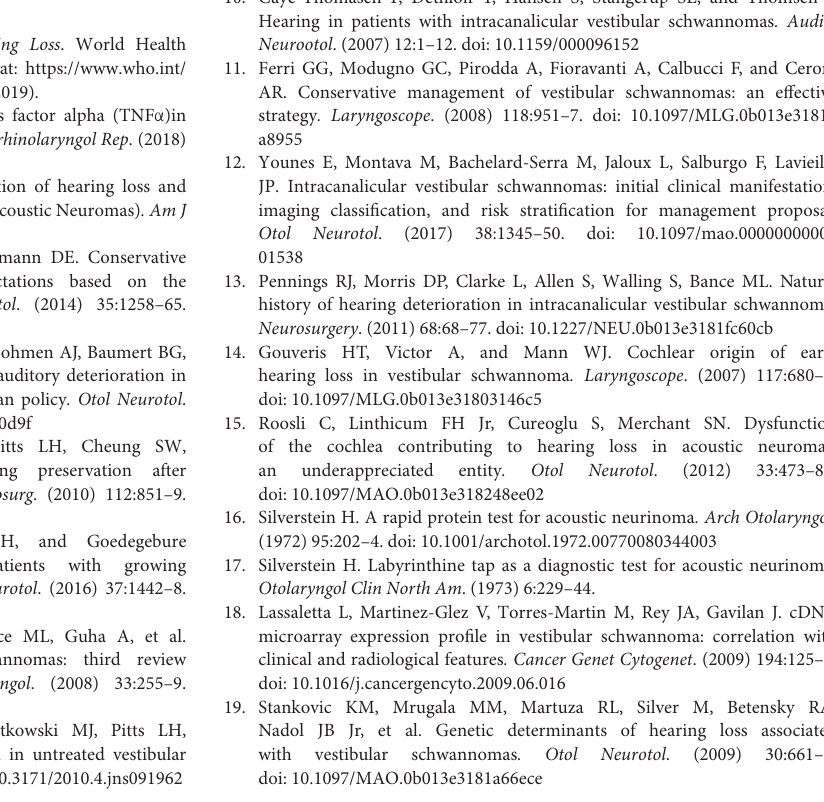
Supplemental Figure 1 | Mean DP amplitude (2f1-f2) vs. level functions for f2 =16 kHz (A) , 24 kHz (B) and 32 kHz (C) at 6 h post-perfusion for the three groups. The control group was perfused with artificial perilymph. The prevention group received etanercept 2 h prior to intracochlear TNF- α perfusion. The differences among groups were not statistically significant. Error bars represent SEM. Figure legend in (A) also applies to (B,C)